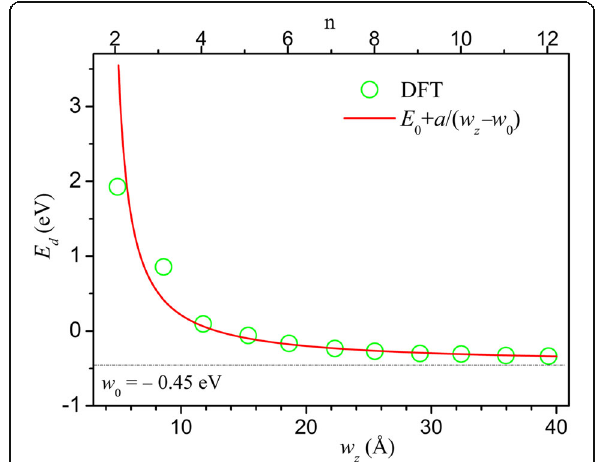
Fig. 3 The minimal energy differences E d between the right and left edge states near the Fermi energy in n -HZZH nanoribbons are shown versus n and w z . The fit curve is in red